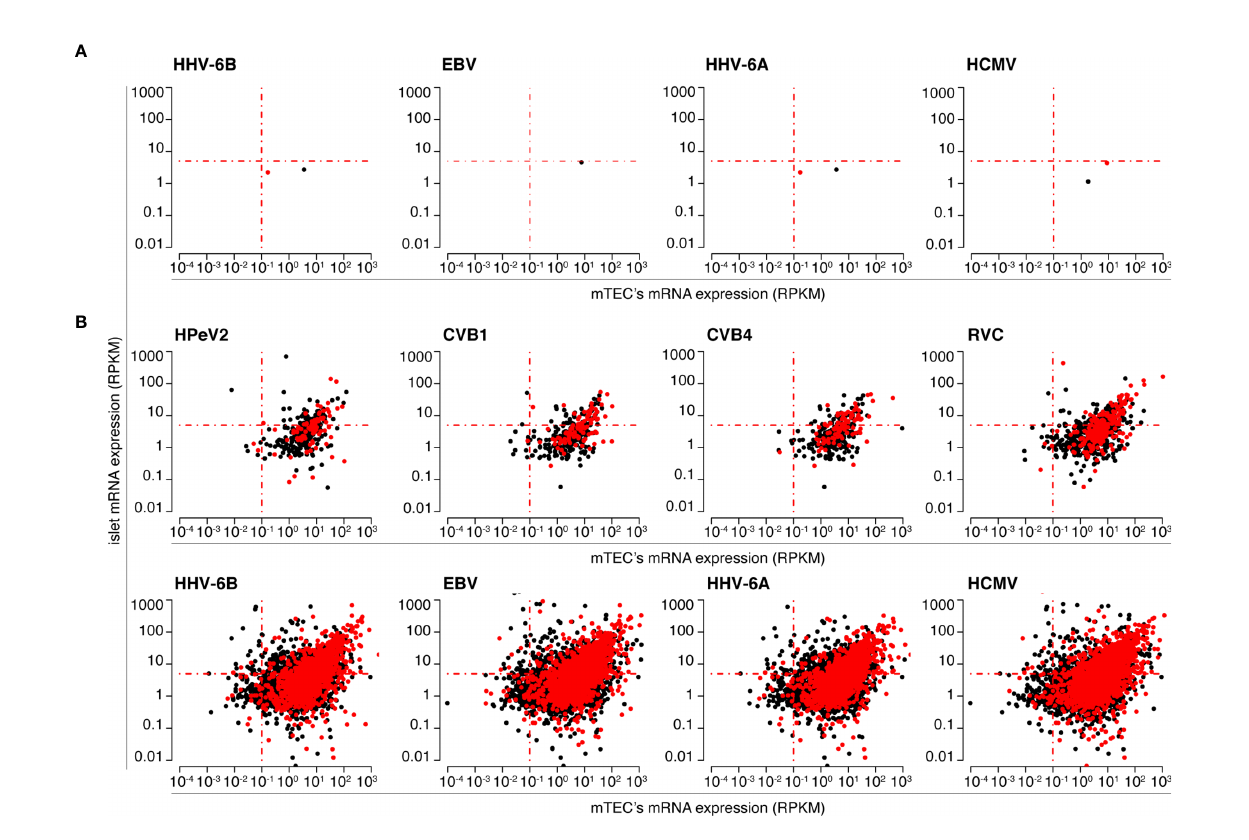
FIGURE 4 | Human pancreatic islets and mTECs ’ mRNA expression of antigens potentially carrying HLA-A*02:01-restricted viral-human non-spliced and cis -spliced zwitter peptide candidates. The scatter plots depict the distribution of RPKM of mRNA of human antigens, as measured by Gonzalez-Duque and colleagues (19) in human pancreatic islets and mTECs, that theoretically can carry viral-human zwitter (A) non-spliced and (B) cis -spliced epitope candidates. Scatter plots are divided based on the corresponding theoretical virus origin. In (A) only four out of eight viruses are shown because for four viruses no viral-human non-spliced peptide candidates with the required characteristics were identi fi ed. Black dots represent antigens carrying epitope candidates predicted to bind the HLA-A*02:01 allele. Red dots represent antigens carrying epitope candidates predicted to bind the HLA-A*02:01 allele and located in hotspots, according to the IEDB